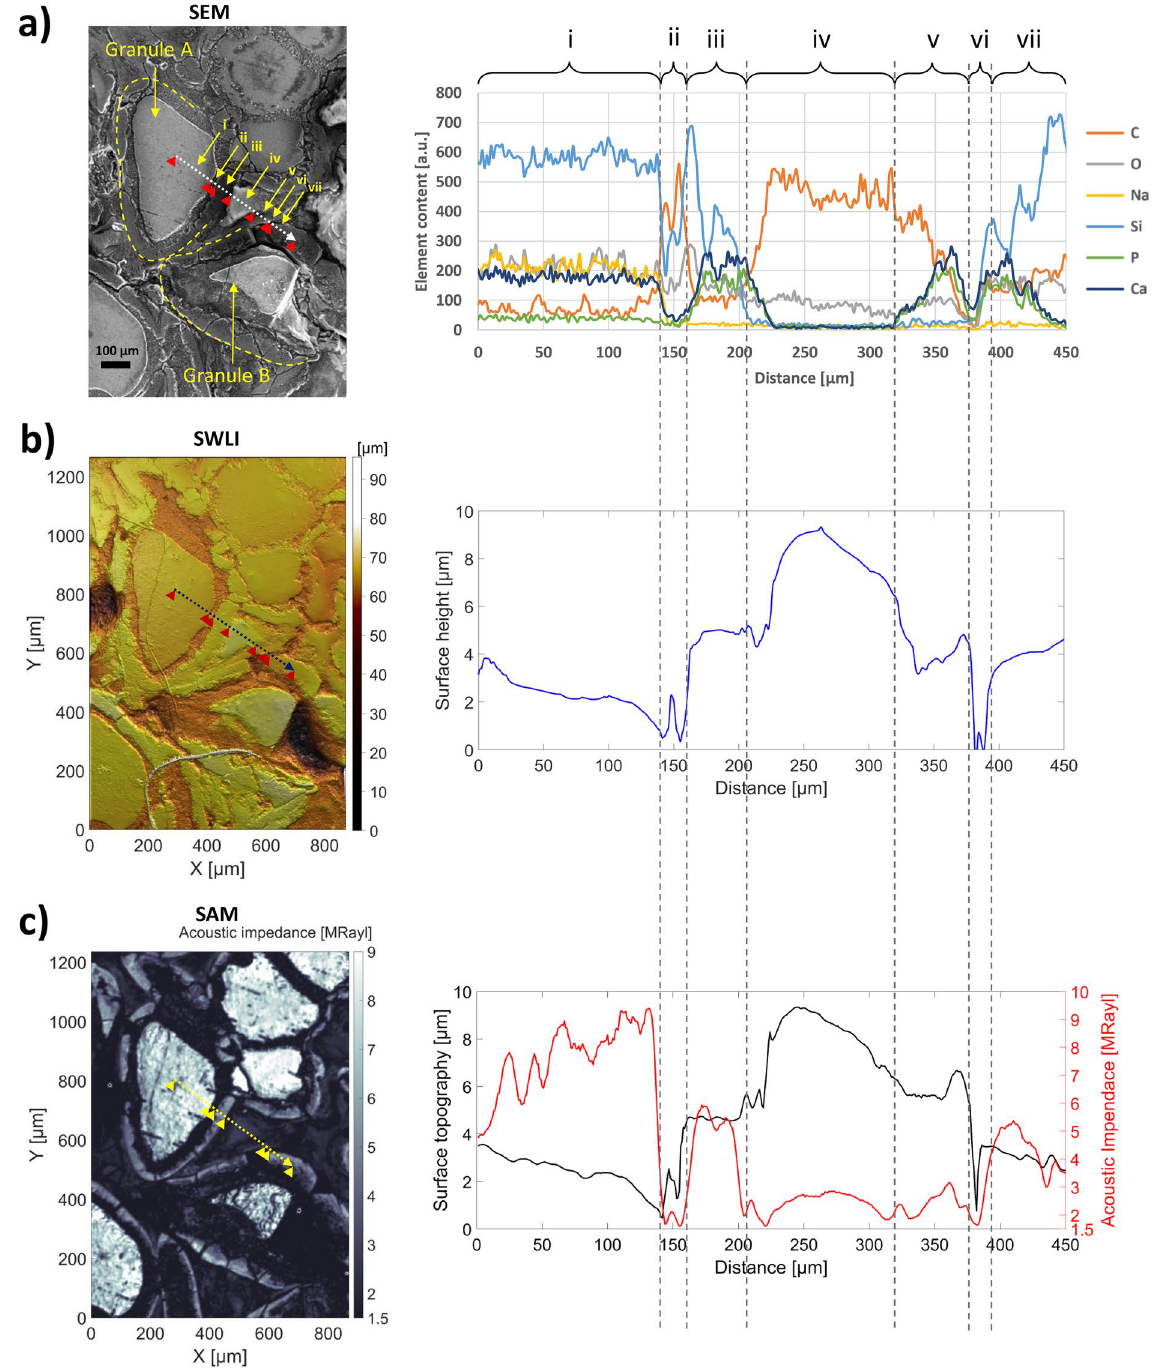
Figure 1. Bone growth measured with SEM–EDX ( a ), SWLI ( b ), and CESAM ( c ). ( a ) SEM image of BAG granules A and B (left) and EDX elemental analysis of the content along the indicated scan line (right). ( b ) SWLI image of the sample (left) and topography along the scan line (right). ( c ) CESAM acoustic impedance map of the sample (left), and acoustic impedance (red) and topography (black) along the scan line. Regions of interest (i–vii) related to stages of bone formation (glass granule, Si-layer, HA-layer, epoxy, non-mineralized bone tissue, HA-layer, Si-layer) are indicated in each figure and discussed in detail in corresponding paragraphs. The acoustic impedance ( c , red line) along the scan line is well explained by the elemental analysis from SEM– EDX ( a ), and the topography maps from SWLI ( b ) and CESAM ( c ) are in good agreement. Thus, CESAM encapsulates the relevant information for bone growth